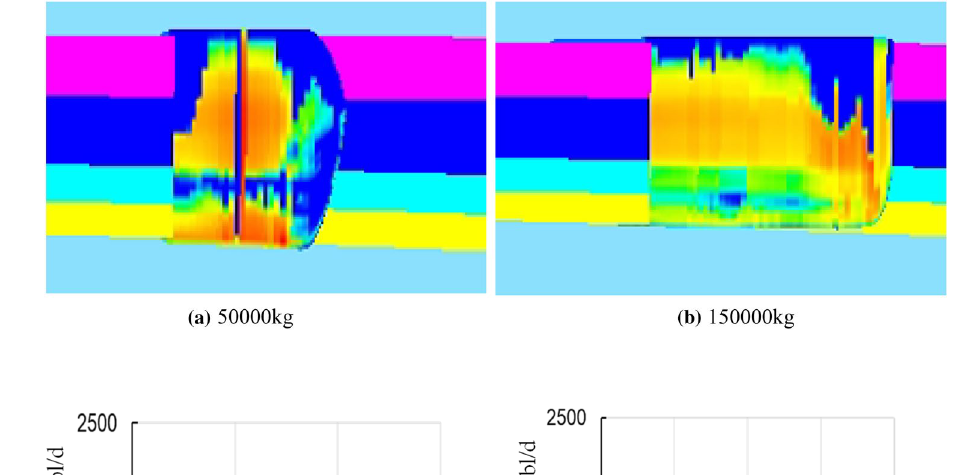
Fig. 22 Productivity changes under various